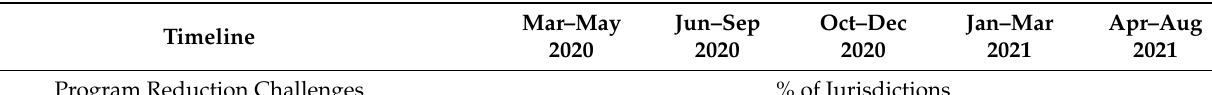
Table 3. Timeline of program reduction challenges and recovery adaptations between March 2020 and August 2021